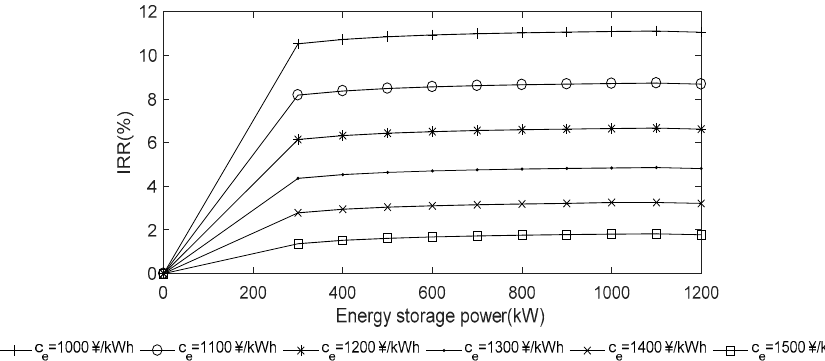
Figure 13. Economics of users participating in load peak shaving services under different peak-to- valley electricity price.